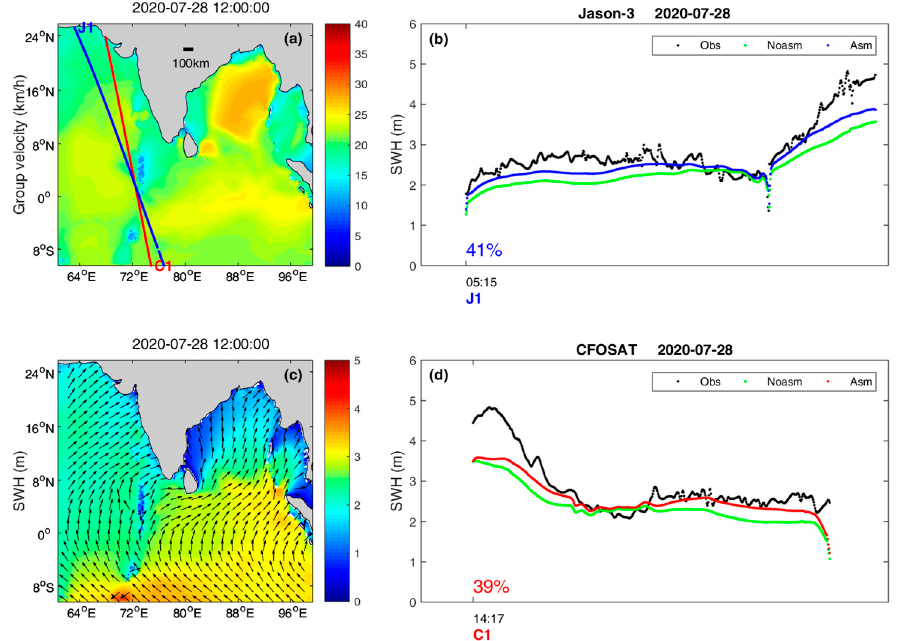
Figure 8. Case C: SWH time series at orbit tracks on 28 July 2020. ( a ) Color represents group velocity in km/h. Blue and red dotted lines indicate orbit tracks of Jason-3 and CFOSAT, respectively. Location of character J1/C1 indicates the start of the orbit track. ( b ) Black dotted lines indicate Jason-3 measurements; blue and green lines indicate SWH of model outputs with and without assimilation of Jason-3; percentage represents improvement rate of mean absolute error of SWH with assimilation compared to without assimilation. ( c ) Color and arrows represent SWH and mean wave direction of model outputs without assimilation. ( d ) Black dotted lines indicate CFOSAT measurements; red lines and green lines indicate SWH of model outputs with and without assimilation of Jason-3; percentage represents improvement rate of mean absolute error of SWH with assimilation compared to without